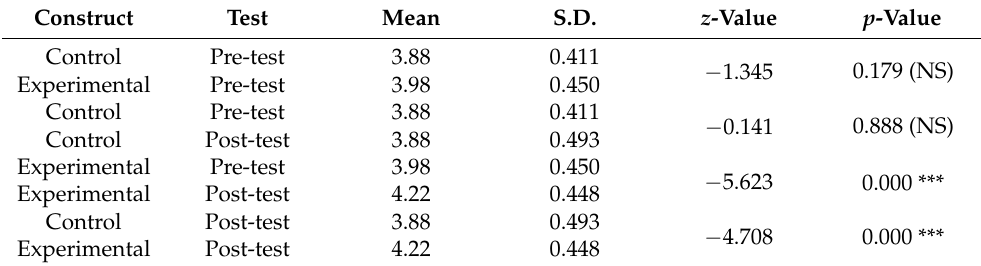
Figure 3. Mean values for Control and Experimental Groups and their significance of mean differences. Table 7. Wilcoxon rank-sum tests and Wilcoxon signed-rank tests between Control and Experimental Groups.